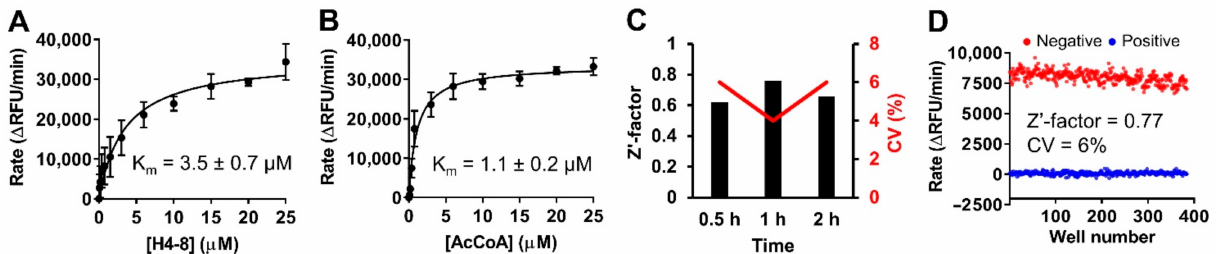
Figure 4. Optimization for fluorescence ThioGlo4 assay. ( A , B ) Re-determination of K m values of H4-8 and AcCoA in 384-well format using the BioTek Synergy Neo2 microplate reader. ( C ) Assay performance (Z (cid:48) -factor and %CV) at incubation time of 0.5, 1, and 2 h. ( D ) Assay performance in a 384-well format. Red dots: 384 wells of negative controls. Blue dots: 384 wells of positive